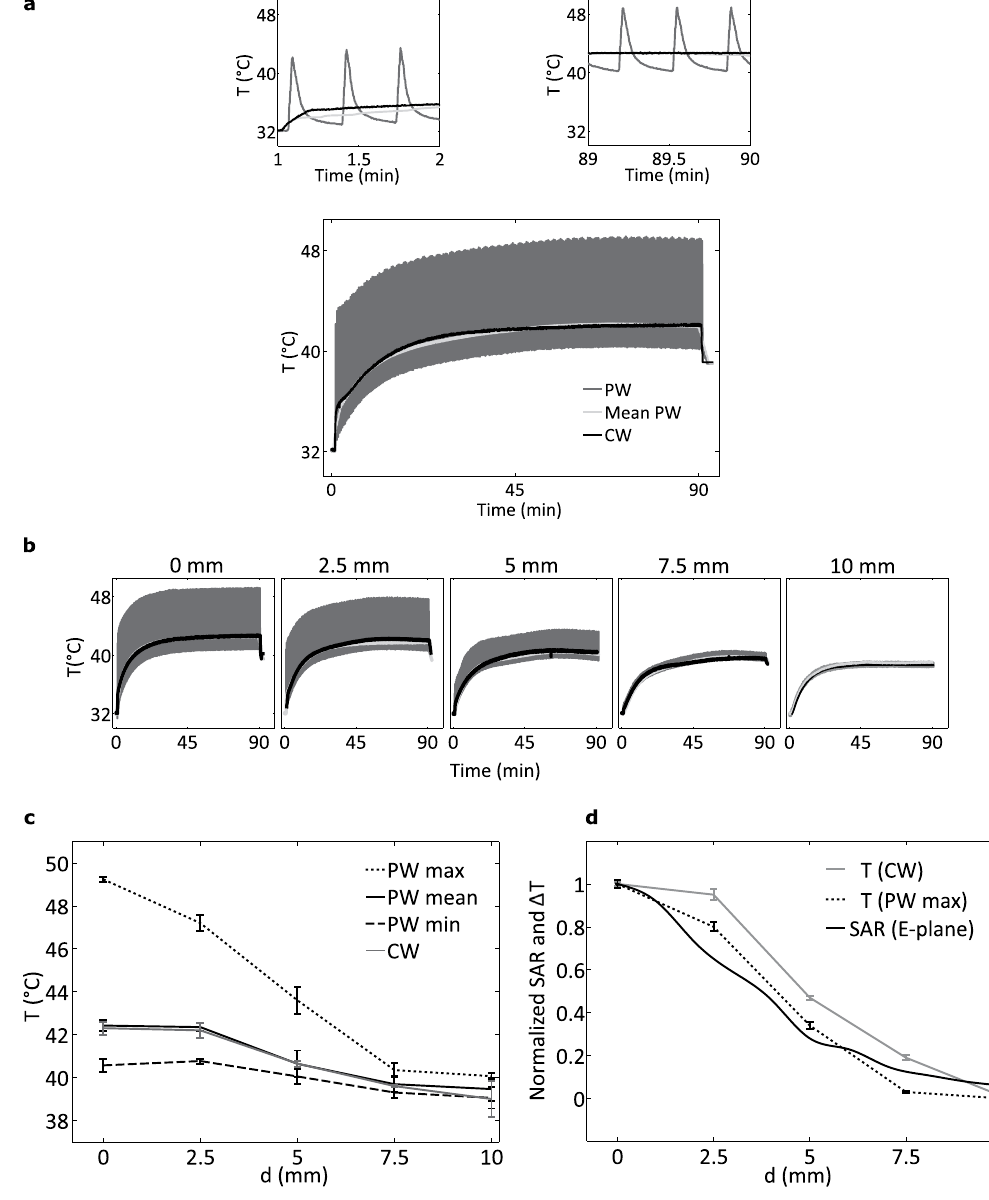
Figure 2. Temperature measured at the bottom of the exposed well. ( a ) Temperature dynamics in the center of the well bottom for PW and CW exposures. The subplots on the top illustrate the zoom for 1–2 min and 89–90 min intervals. ( b ) Temperature dynamics at different distances from the center of the well bottom in the lateral direction for 90 min of exposure (the locations of TC sensors are schematically illustrated in Fig. 1b). ( c ) Corresponding steady-state temperature rise after 90 min of exposure. ( d ) Normalized SAR along the E-plane and temperature rise Δ T (defined as the difference between the steady-state temperature at considered location and at 10 mm). Error bars indicate the SEM for three independent